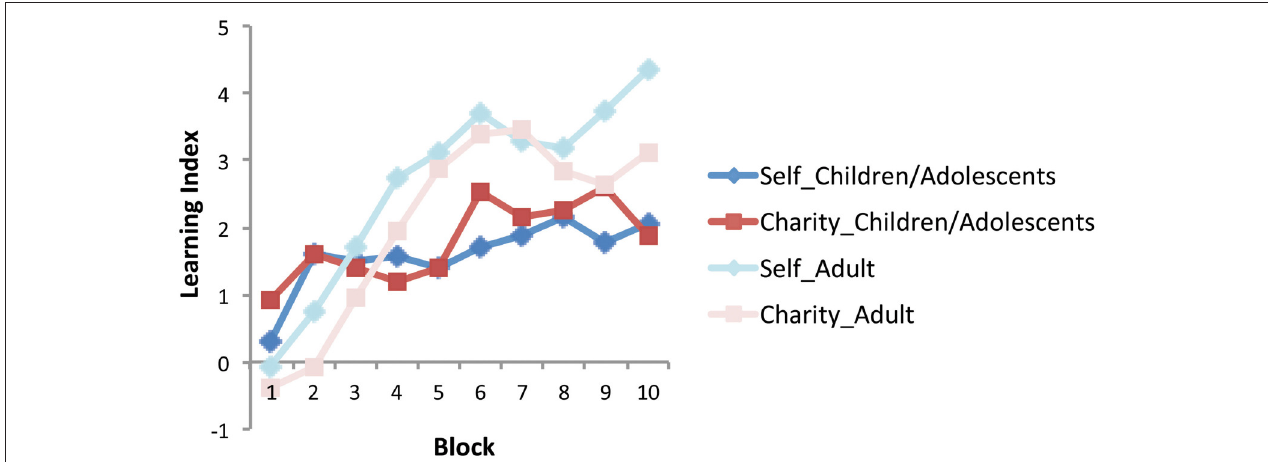
FIGURE 2 | Learning index across the 10 blocks (10 card draws each) for self and charity domain in children/adolescents and adults. The results from adults were previously reported in Kwak et al. (2014). Learning index was independently calculated in the self and charity domain as the difference in the number of gain decks and loss decks